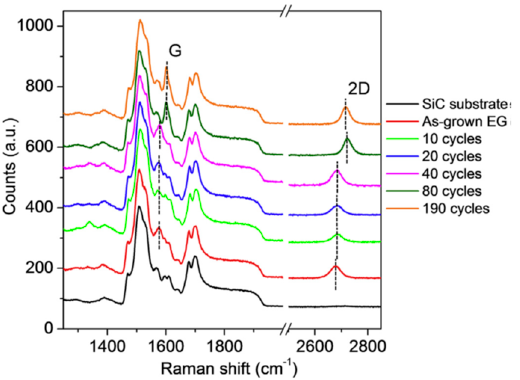
Figure 15. Typical Raman spectra of monolayer epitaxial graphene before and after Al 2 O 3 deposition with 10, 20, 40, 80, and 190 ALD cycles. Raman spectrum of the graphene-free 4H-SiC sample is also shown [59]. Copyright 2020 Elsevier Ltd., Amsterdam, Netherlands.